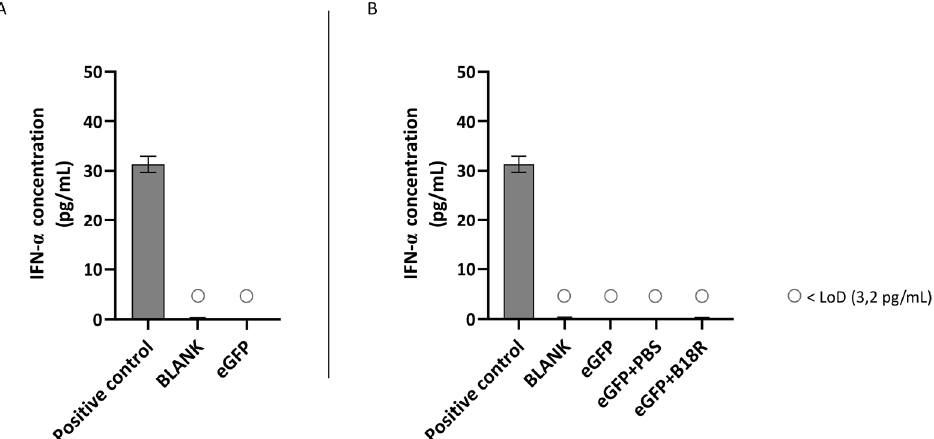
Figure 6. IFN-α production of MIO-M1 cells transfected with mRNA-MessengerMAX lipoplexes with or without B18R co-incubation as determined by ELISA (n = 3 × 3). ( A ) Absolute INF-α concentration in the supernatant 24 h following transfection of MIO-M1 cells with mRNA-MessengerMAX complexes without B18R addition. ( B ) IFN-α concentration, normalized to the group solely receiving mRNA-MessengerMAX complexes (eGFP), in the supernatant of MIO-M1 cells 24 h after transfection with mRNA-MessengerMAX complexes with or without B18R addition. The lowest concentration of IFN-α that could be detected with the used ELISA assay (LoD) was 3.2 pg/mL. Concentrations below the LoD are assigned with ○ . Both graphs contain a positive control with a concentration of 31 pg/mL derived from the standard curve obtained during the experiment.